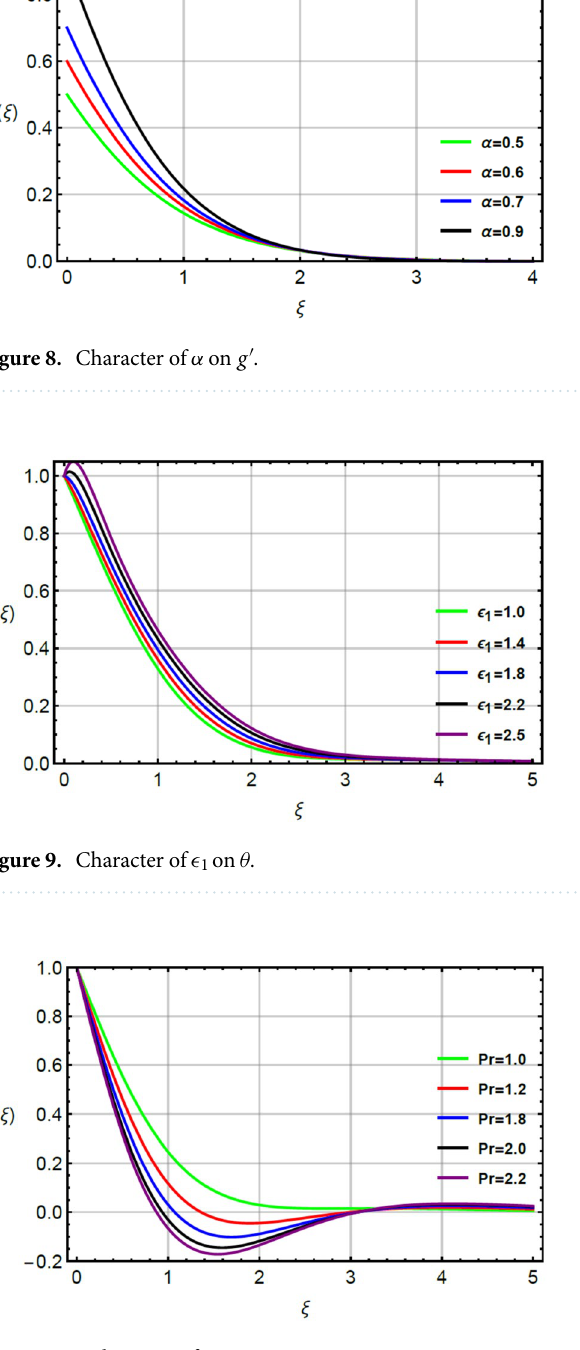
Figure 10. Character of Pr on θ